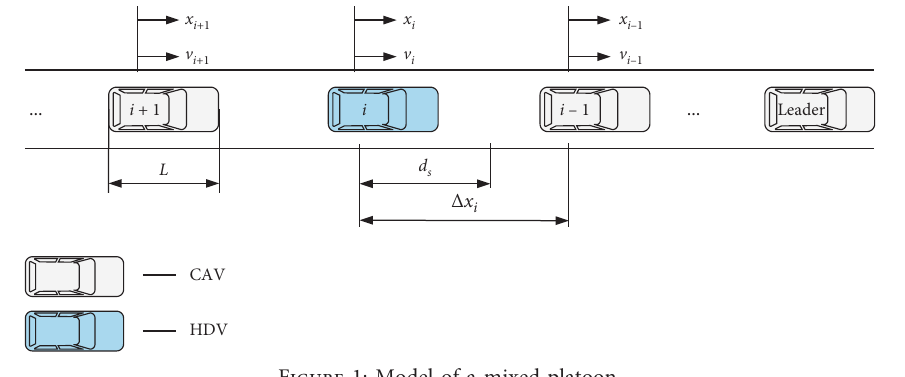
Figure 1: Model of a mixed